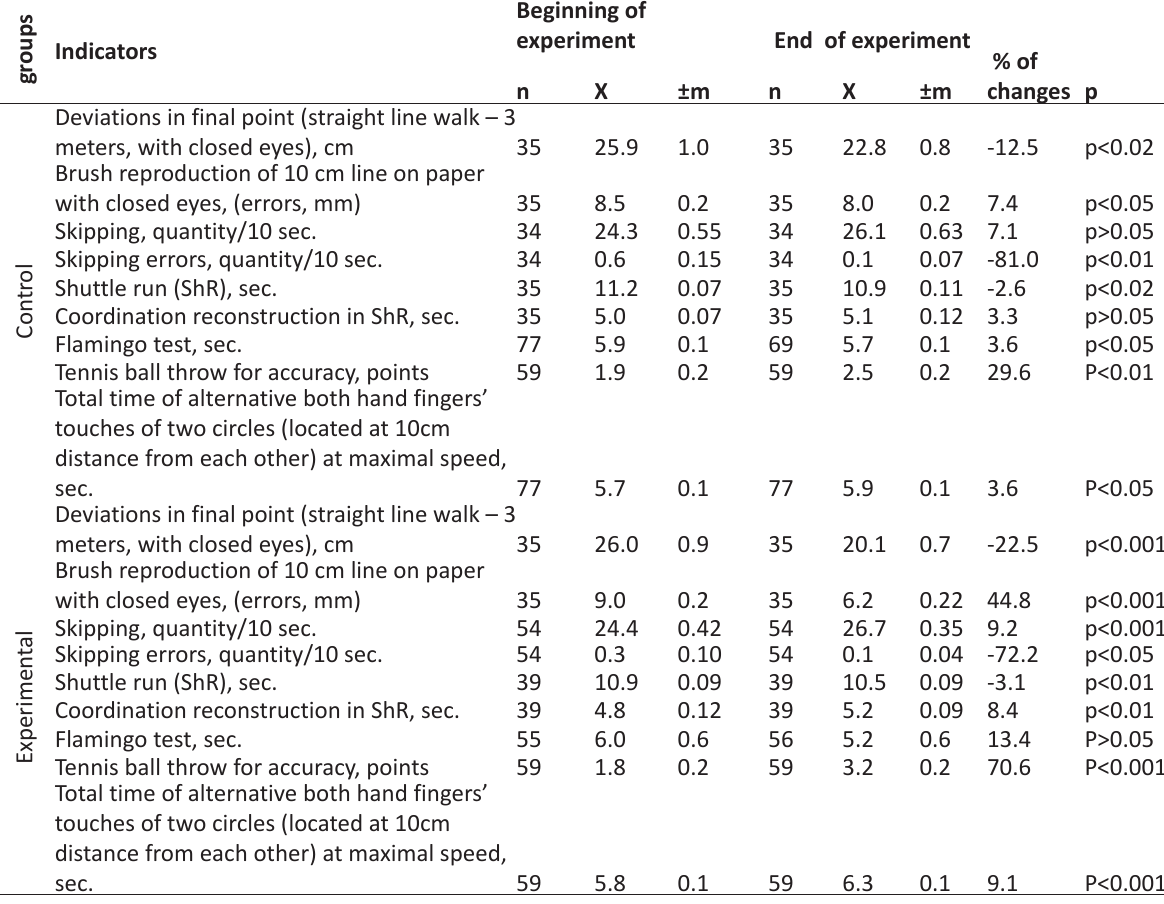
Table 1. Indicators of motor control quality in control and experimental groups’ girl students at the beginning and at the end of the research up s Indicators o g r Deviations in final point (straight line walk –